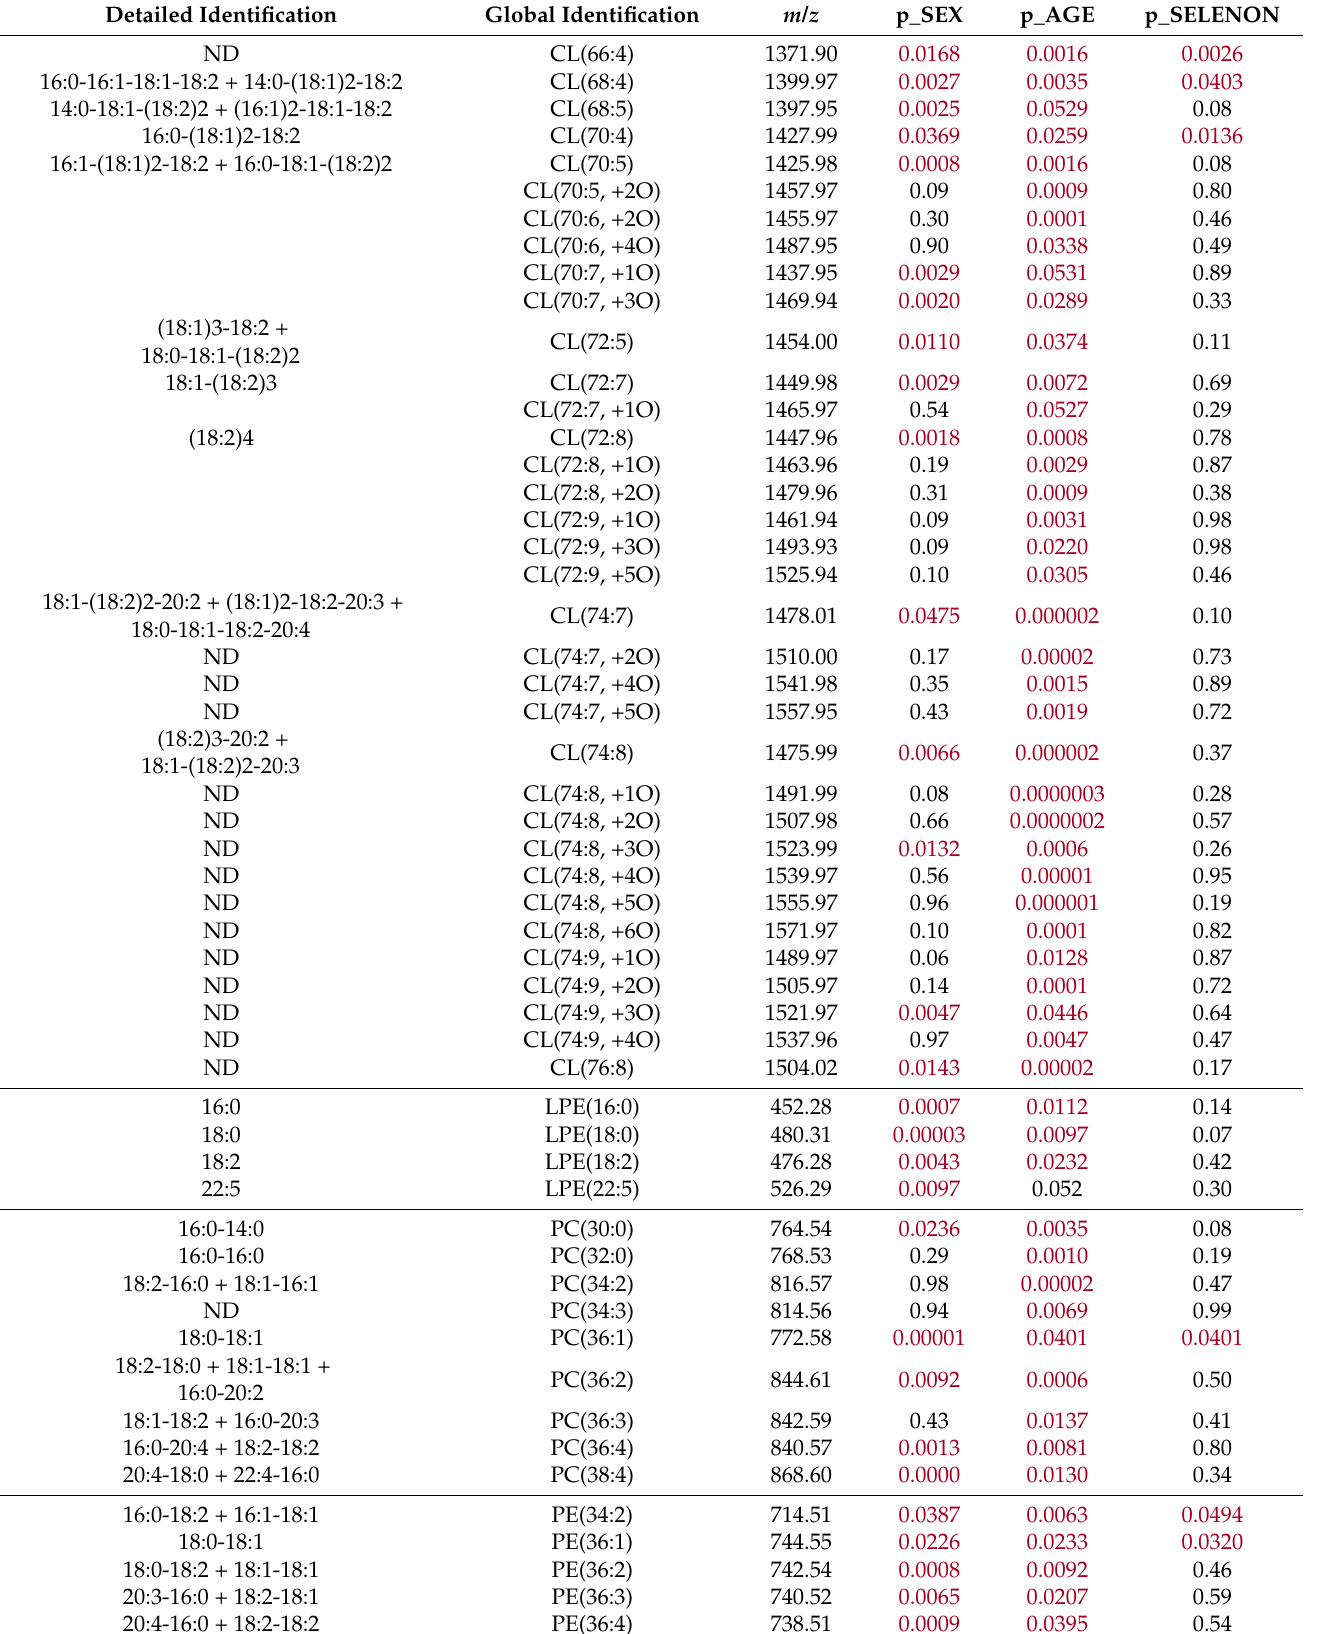
Table 3. Age-significant PL in